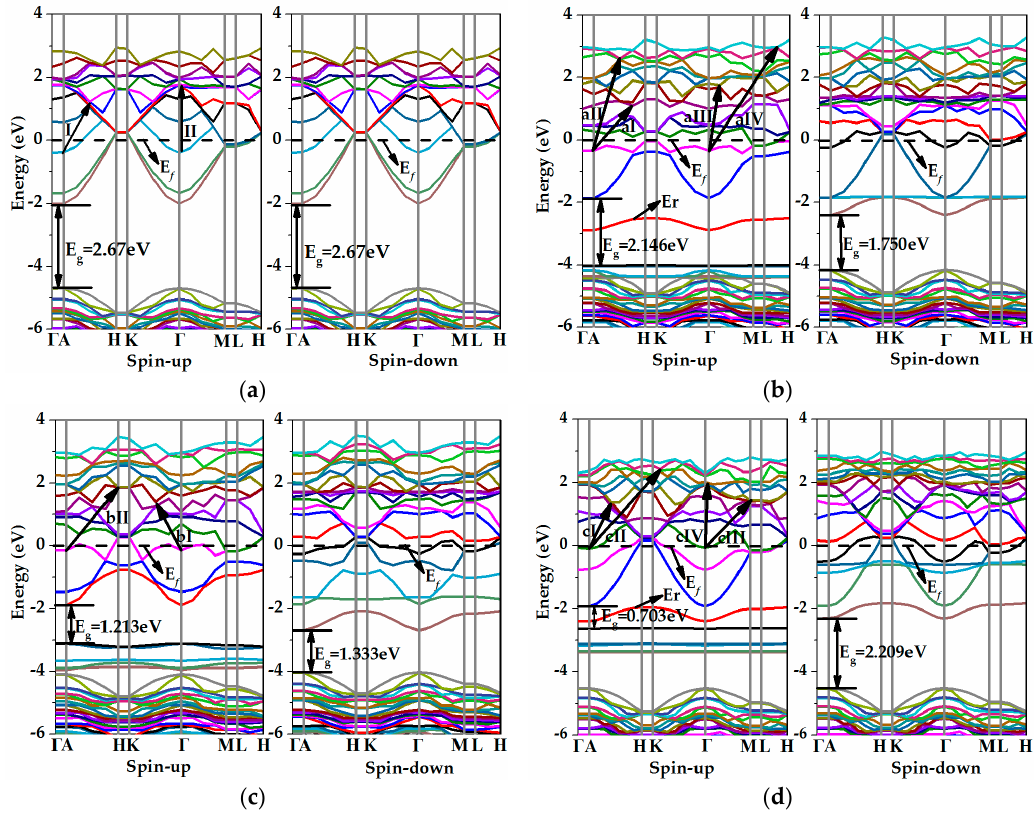
Figure 4. The band structures of ( a ) pristine ZnO (0001) and iron atom adsorbed on ( b ) the H 3 site, ( c ) the T 4 site, and ( d ) the Top site of the ZnO (0001) surface via the GGA+U method.